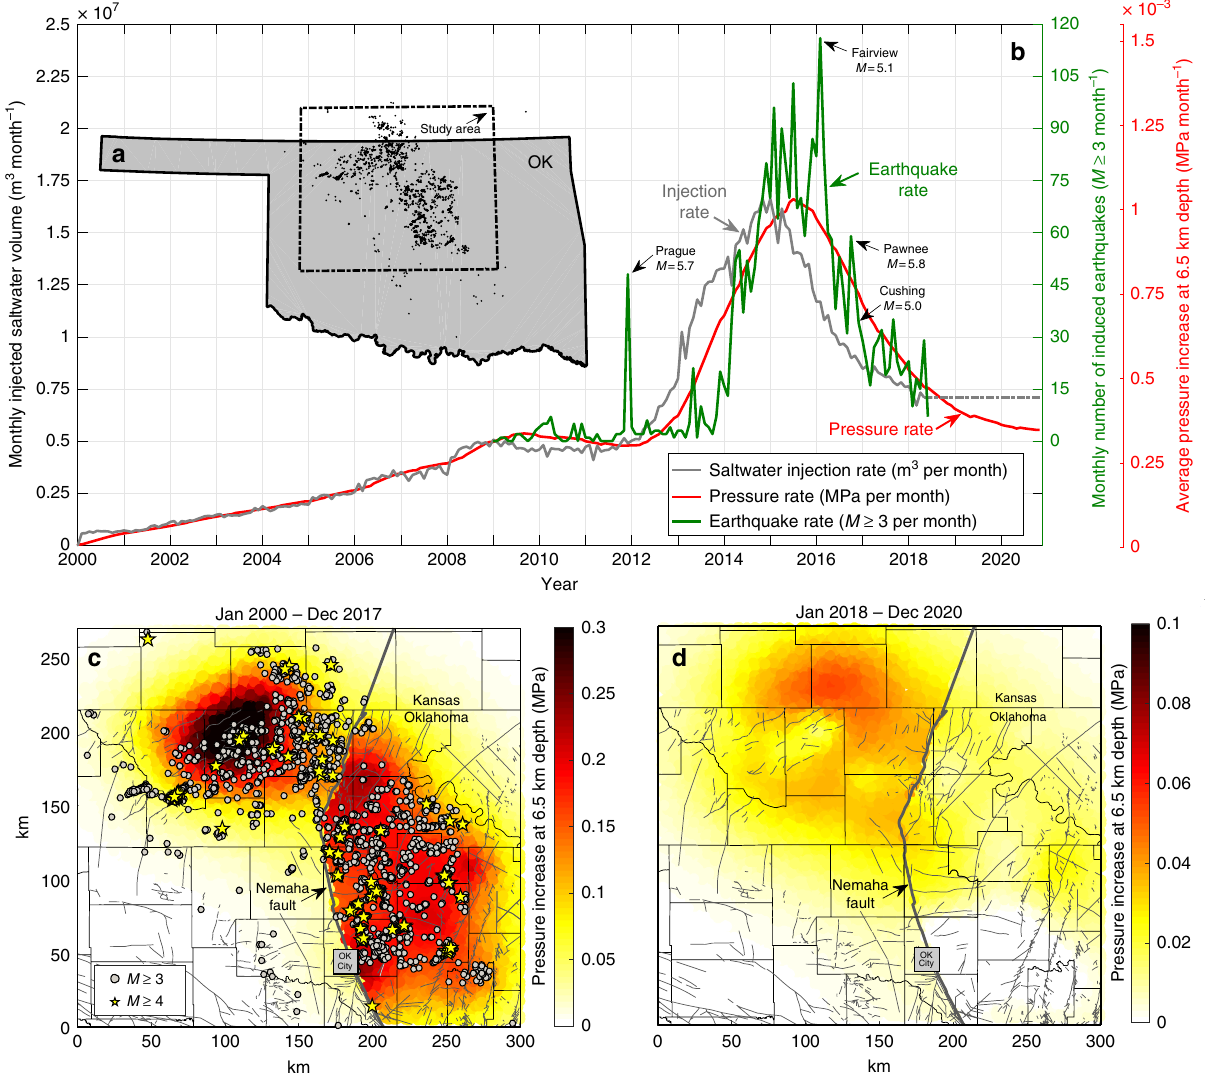
Fig. 1 Saltwater injection, induced earthquakes and pressure increase in Oklahoma and Kansas. a The study area is shown by the dashed line. Black dots show M ≥ 3 earthquakes from Jan 2009 through May 2018. b Total monthly saltwater injection rate (grey), observed earthquake rate (green) and average modelled rate of pressure increase (red) in the study area. Our diffusion model predicts increasing pressure at depth through 2020 (red). However, the rate of pressure increase is slowing down to the level observed in 2009, when seismicity began. c Map of injection-induced pressure increase at depth (Jan 2000 – Dec 2017). Earthquakes ( M ≥ 3 grey dots, M ≥ 4 yellow stars) generally occurred where injection increased pressure at depth. d Projected future pressure increase (Jan 2018 – Dec 2020). With the exception of a region east of Oklahoma City, the pressure is expected to further increase through 2020. Note the different range of the colour schemes used in c and d . Mapped faults in the sedimentary cover 52 ( c and d ) are shown as grey